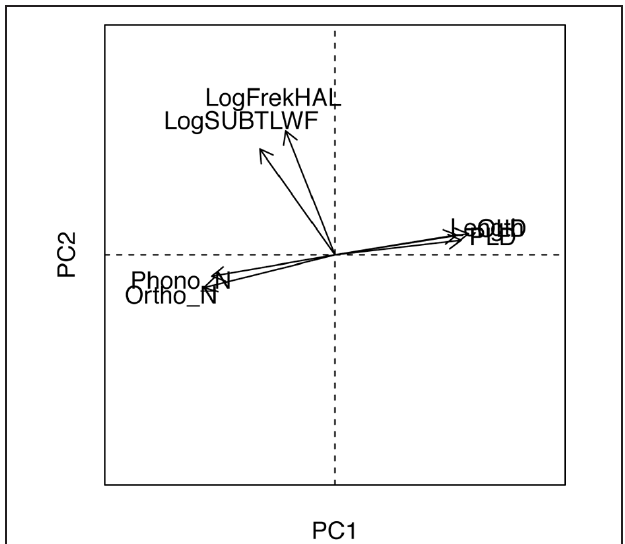
FIGURE 2 | Vector representation of item variables in the plane defined by the form (PC1) and the frequency (PC2) principal components.